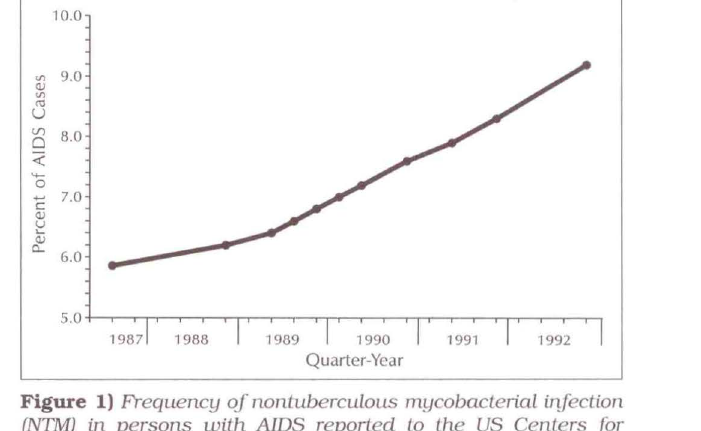
Figure 1) Frequency of nonluberculous mycobacterial irifeciion (NTM) in persons with AIDS reported lo the US Centers for Disease Control andPreveniion. 1987 t.o 1992. Cumulaiive cases of NTM are shown as a percentage of cumulaiive AIDS cases reported by that date. (Nearly all cases of NTM were due to Mycobacterium avium complex)